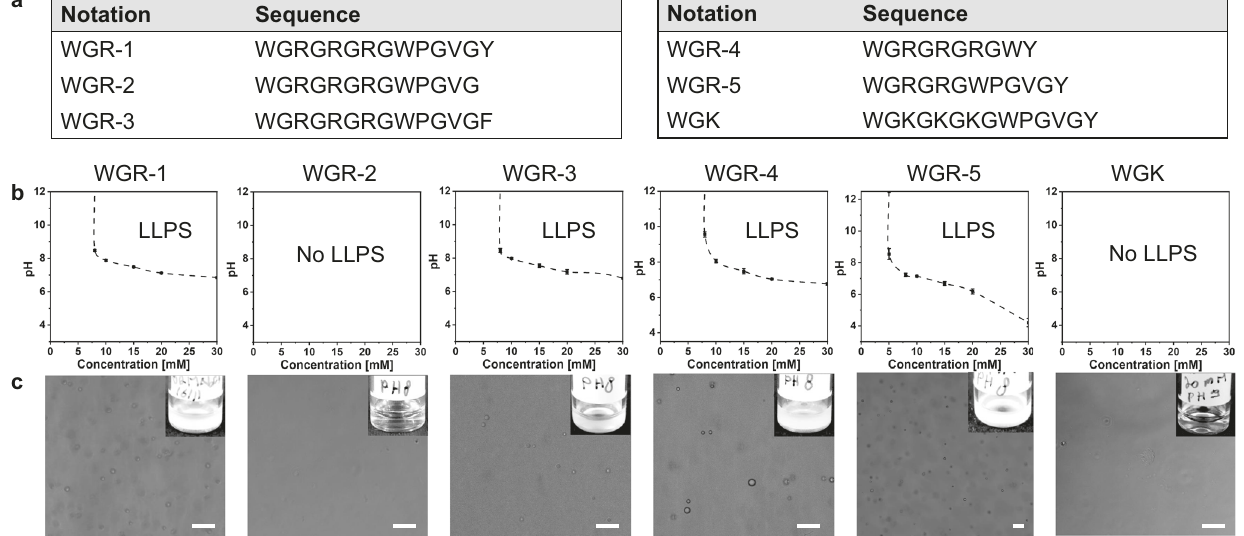
Fig. 2 | Peptide sequence controls LLPS propensity and droplet formation. a Table of the designed peptide sequences. b Phase diagram of the peptides as a function of peptide concentration and pH, in tris buffer with 0.2M NaCl, at room temperature. LLPS was not observed for WGR-2 and WGK. Data are presented as mean values of n =3+/ − SD. Source data are provided as a Source Data fi le.